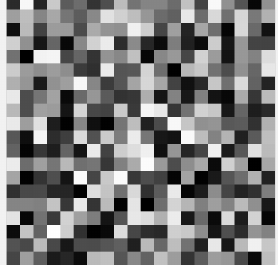
Figure 8. Converting one-dimensional time-domain signals to two-dimensional gray-scale